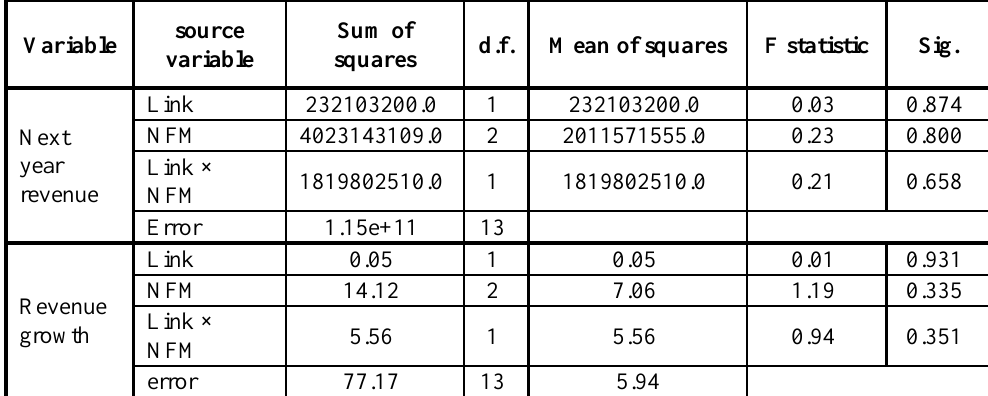
Table 10. two-way ANOVA (non-financial intangible information and causal links for investors with high